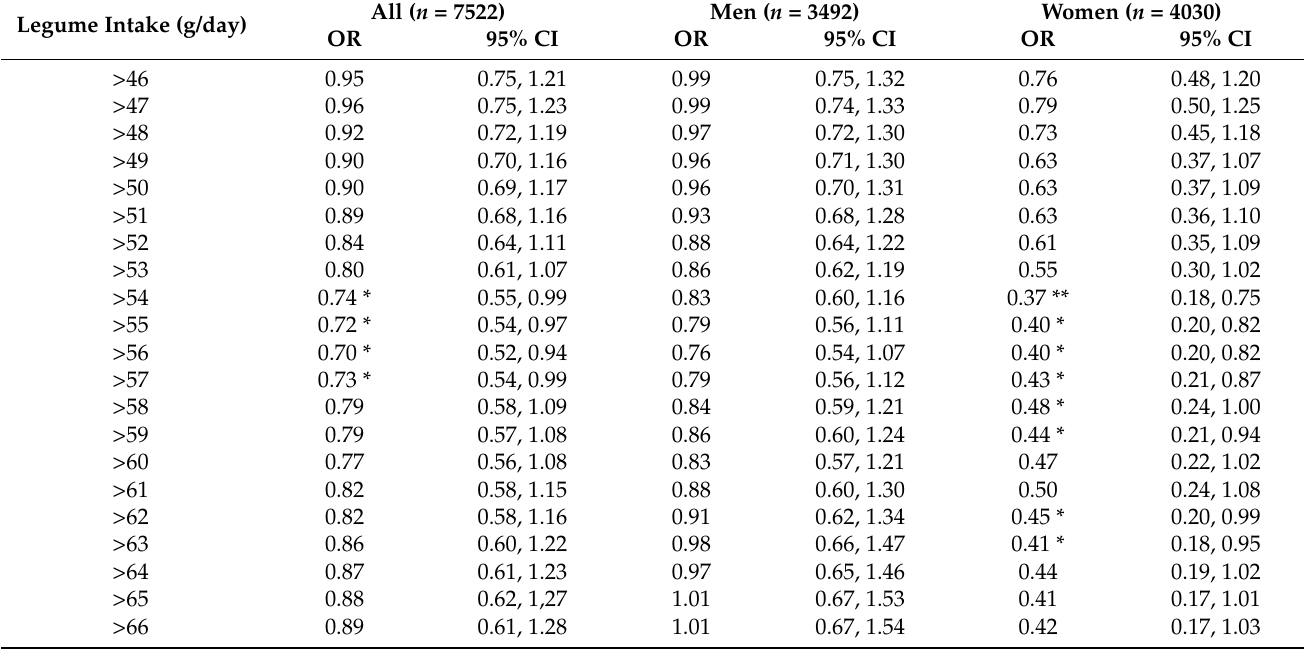
Table 3. Odds of hypertension by grams-per-day legume intake, starting above 45 g per day, using